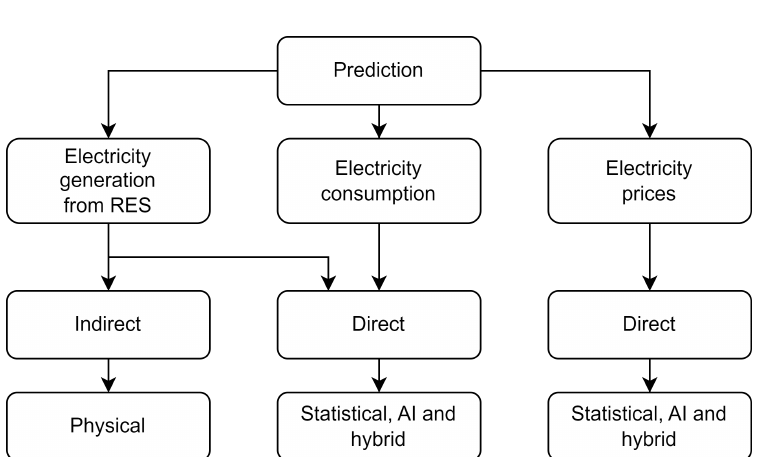
Figure 7. Overview and division of